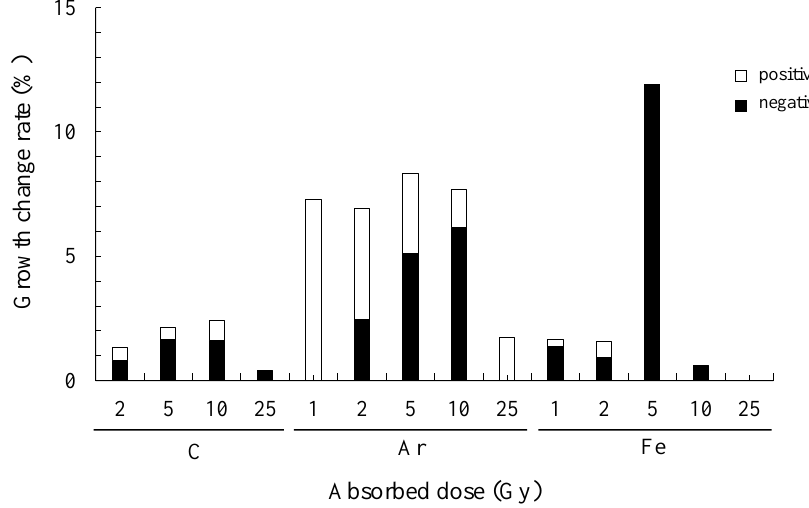
Figure 3. Growth change rate of gerbera obtained by ion beam irradiation.